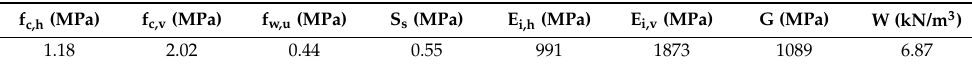
Table 1. Mechanical properties of the infill